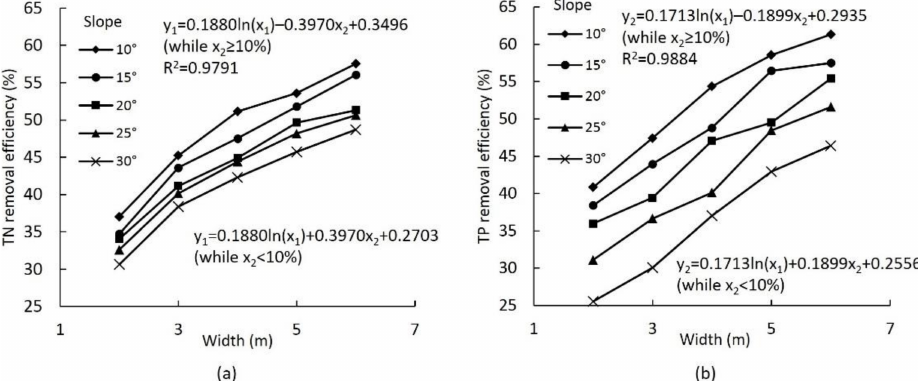
Figure 6. The relationship between the TN and TP removal efficiencies and the width and the slope. ( a ) the relationship between TN removal efficiency, riparian buffer width, and slope, where y 1 is the removal efficiency of TN; ( b ) the relationship between TP removal efficiency, riparian buffer width, and slope, where y 2 is the removal efficiency of